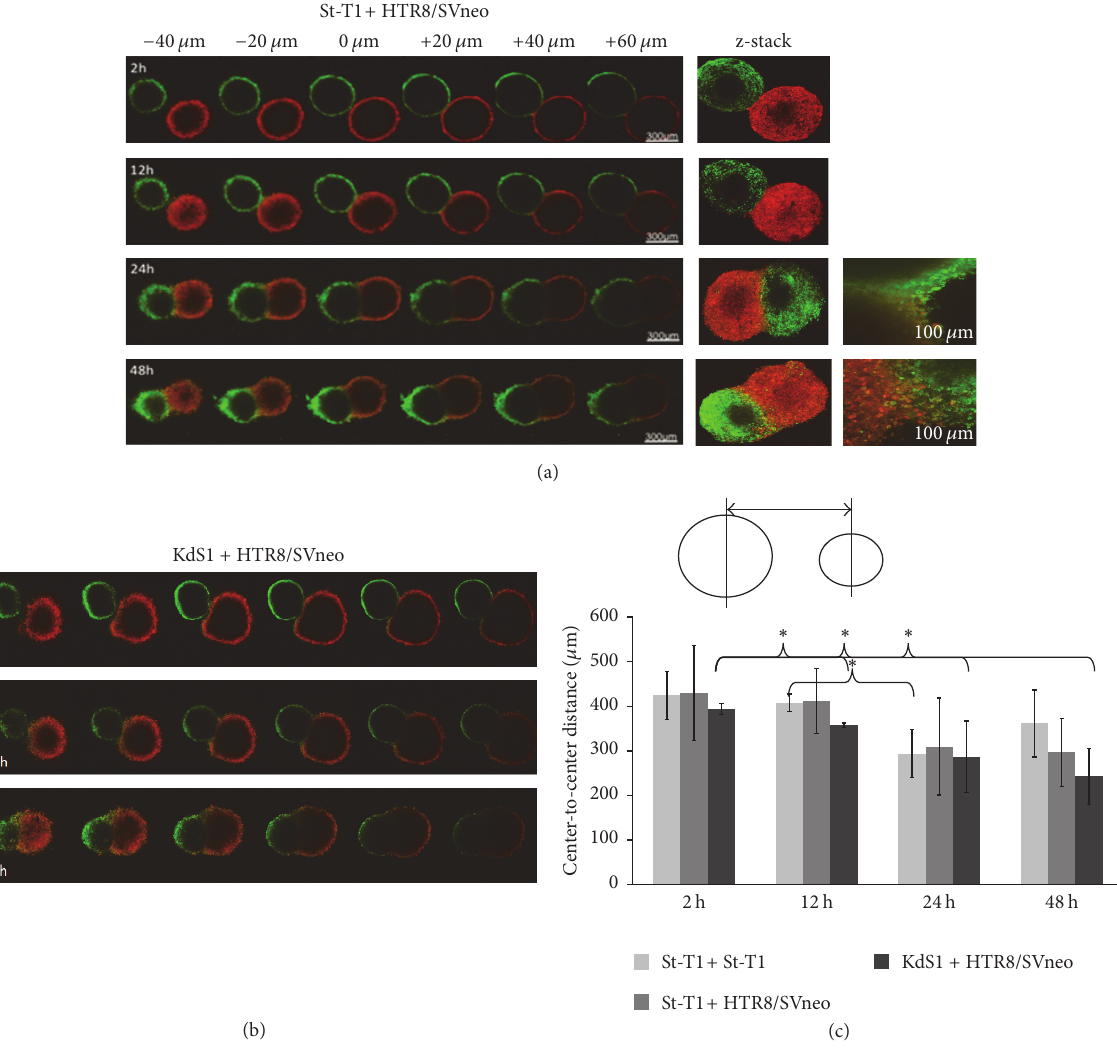
Figure 7: Representative confocal microscopy of St-T1 (a) and KdS1 (b) spheroids (green) cocultured with HTR8/SVneo spheroids (red) incubated for 0–48 h imitating human preimplantation and implantation processes. Measurement of center-to-center distances [ 𝜇 m] (c) was chosen to examine 3D attachment and invasion. Data represents means ± SD with ∗ 𝑝 < 0,05 for trophoblast-endometrium incubated cells versus control (2 St-T1